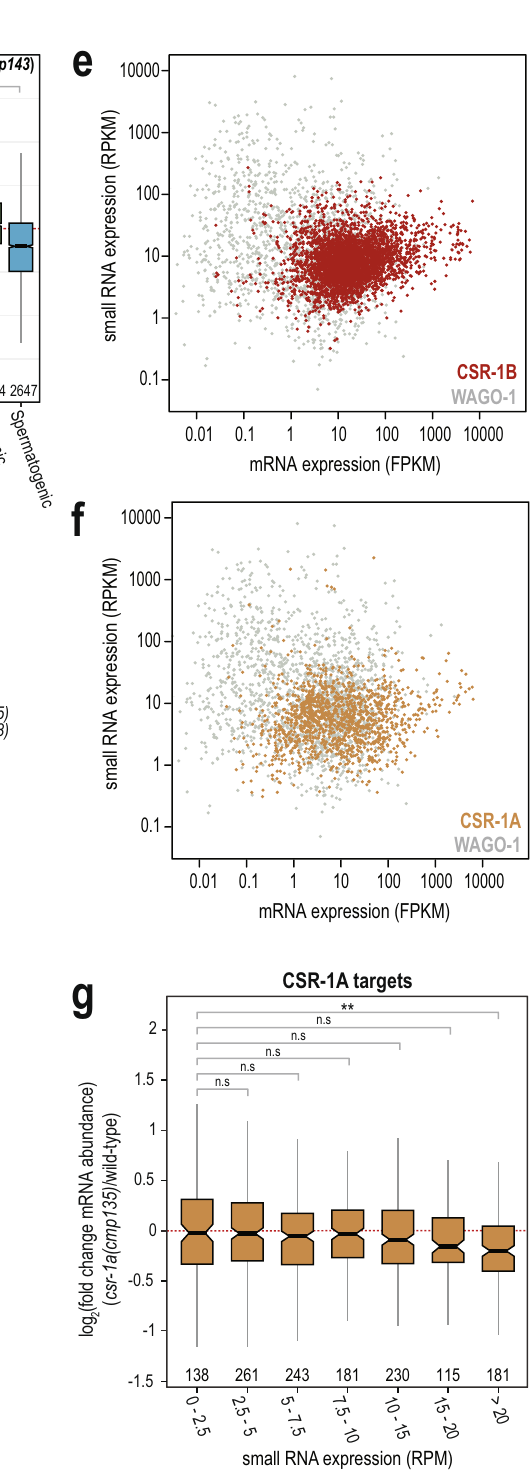
downregulated (DESeq2 adjusted p value of ≤ 0.05) in csr-1a ( cmp143 ) mutants, while 9.7% of CSR-1A targets are signi fi cantly upregulated (DESeq2 adjusted p value of ≤ 0.05) in csr-1a ( cmp143 ) mutants (Fig. 5b). Of the downregulated CSR-1A tar- gets, 82.6% are also spermatogenic genes 28 , while the upregulated CSR-1A targets only include 23.3% spermatogenic genes (Fig. 5b). To con fi rm that some CSR-1A target transcripts are indeed reduced in the csr-1a mutants, we performed RT-qPCR on three spermatogenic genes that were strongly enriched for mapped